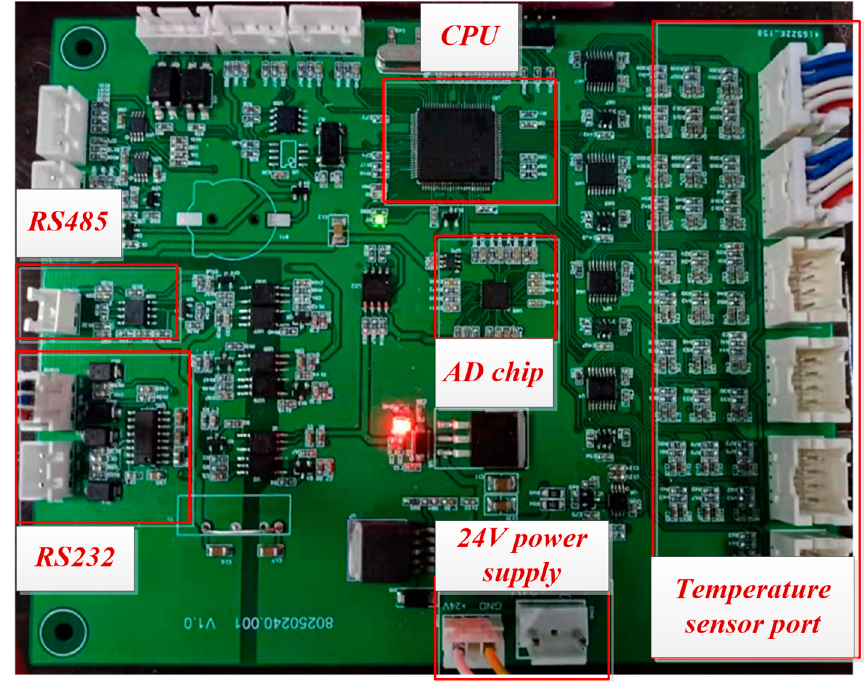
Energies 2022 , 15 , x Figure 5. The hardware structure diagram of the temperature control board. Figure 5. The hardware structure diagram of the temperature control board.